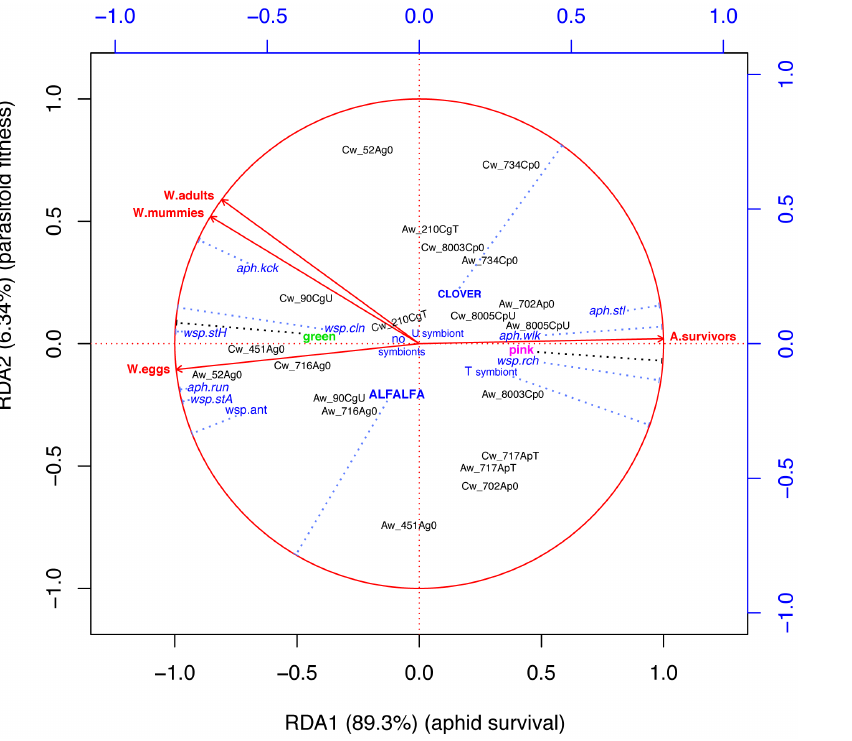
Figure 1. Biplot of RDA on outcomes of encounters of A.ervi with potential hosts belonging to 10 clones of two crop plant variants of the aphid A.pisum . Responses shown as solid arrowed lines are related to 12 explanatory variables (dotted lines) representing aphid and wasp behaviors, aphid body color, aphid facultative symbiont, and aphid host plant (alfalfa or clover). Projection of variables on unit circle allows measuring the predictive power of explanatory variables on aphid and parasitoid fitness, as their distances on the circle (see text for